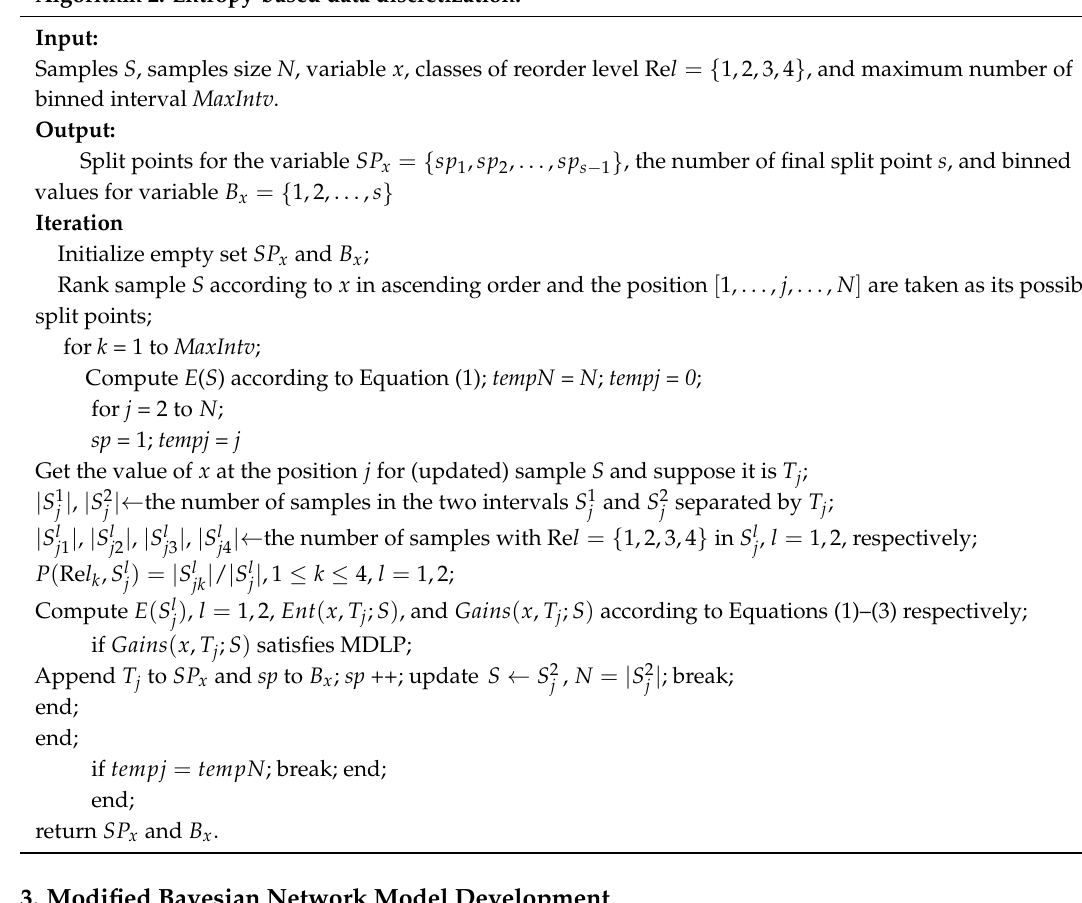
Algorithm 2. Entropy-based data